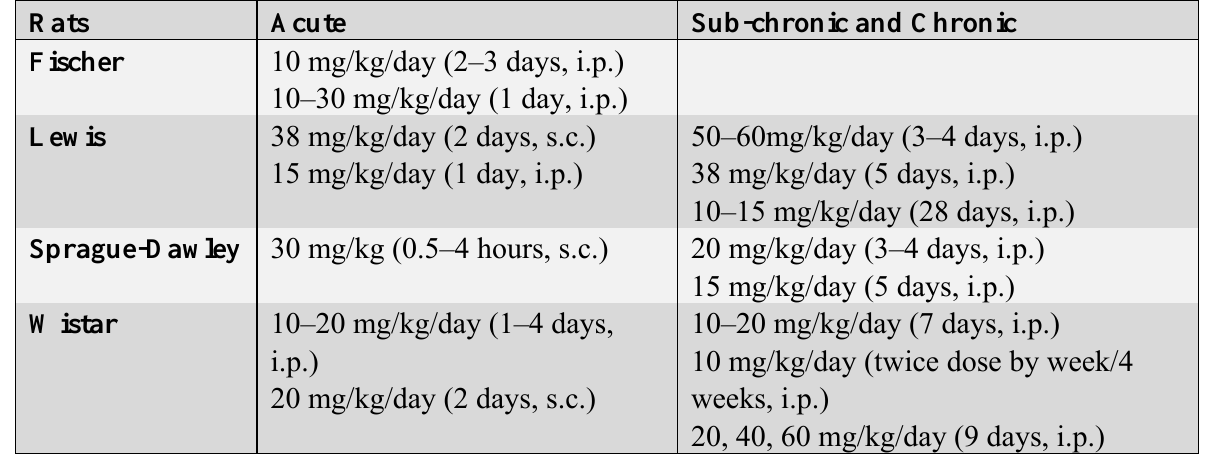
Table 1. Treatment with 3-NP in